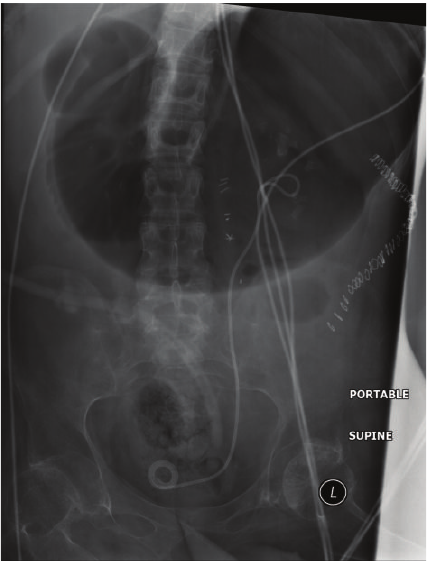
Figure 5: X-ray of abdomen, taken on 11 August 2009, revealed gastric